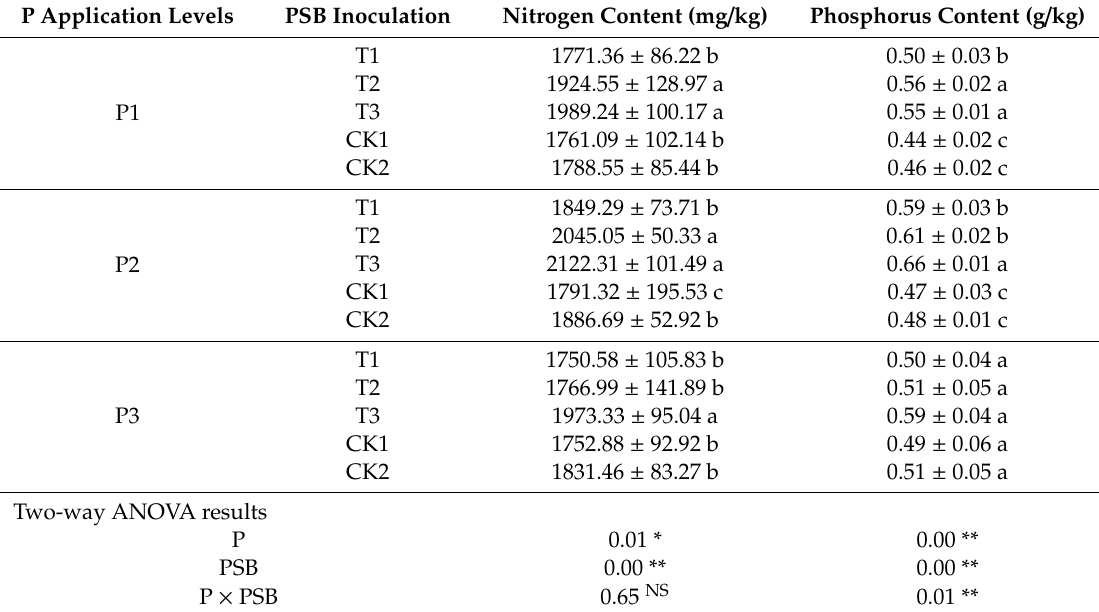
Table 3. E ff ect of PSB on the nitrogen content of C. oleifera